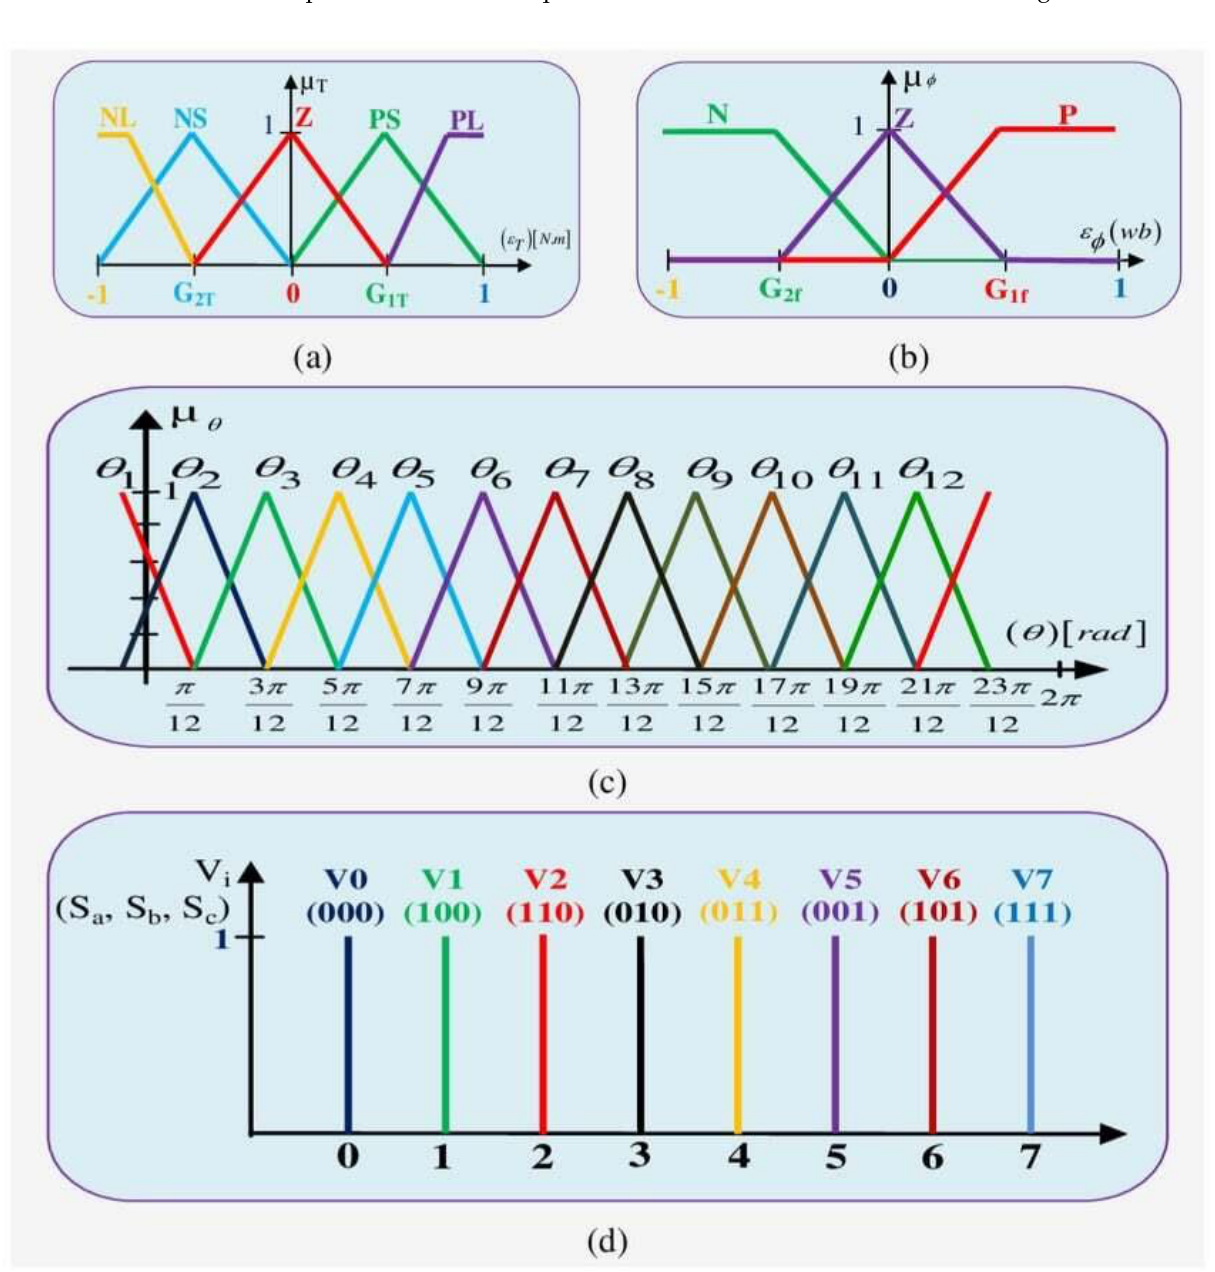
Figure 8. Membership functions of: ( a ) torque error; ( b ) flux error; ( c ) stator flux position, and ( d ) the